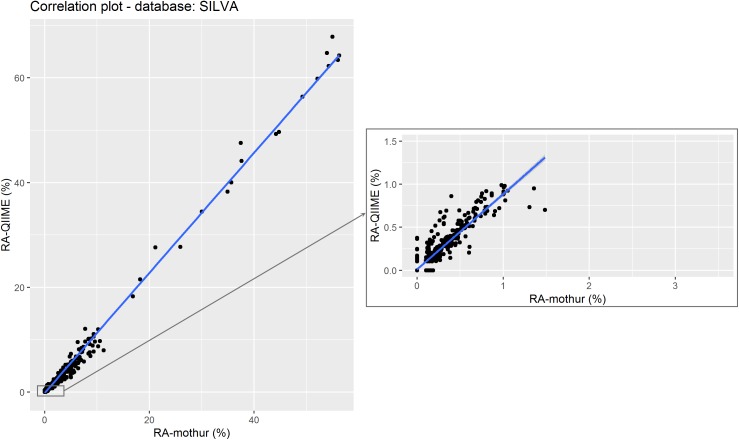
Relative abundance of the different microorganisms (by genera) detected by QIIME and mothur within the 18 samples using SILVA as reference data set. The subset shows the correlation between data with QIIME RA < 1%. Points represent individual RA within each sample.